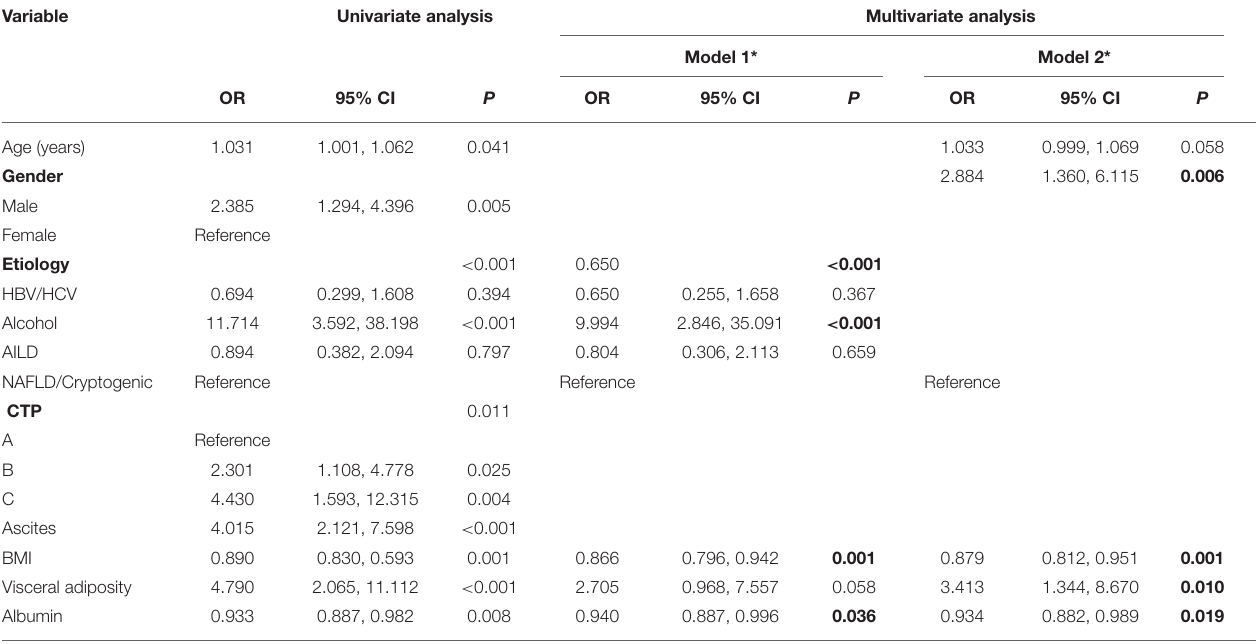
TABLE 2 | Univariate and multivariate analysis for malnutrition risk determined by RFH-NPT.